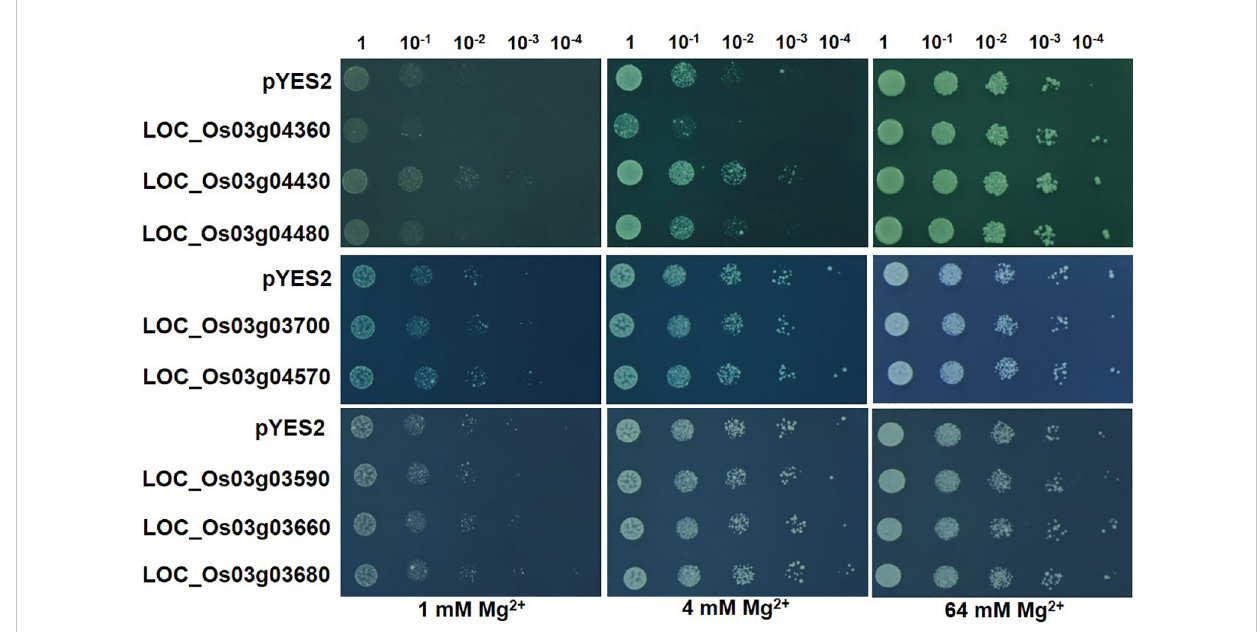
FIGURE 5 Expression of the candidate genes in yeast mutant CM66. Overnight yeast cell suspension of CM66 transformed with empty vector pYES2 or candidate genes were serially diluted (1:10) and spotted on the solid media containing 1, 4 or 64 mmol/L MgSO 4 . Pictures were taken after four days growth at 30°C.